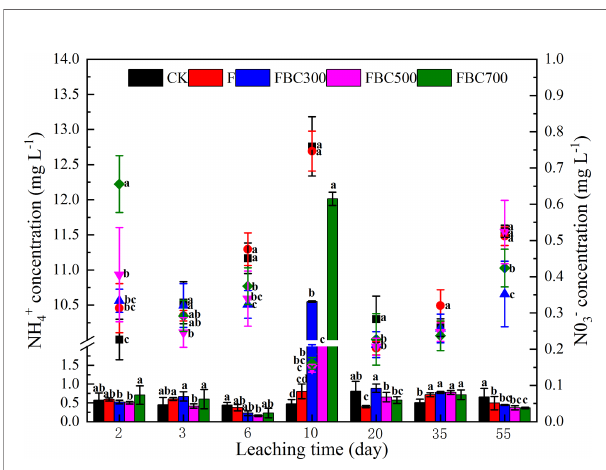
FIGURE 3 | Dynamic changes of surface water ammonium nitrogen (NH + 4 ) and nitrate nitrogen (NO − 3 ) during 55 days column leaching of paddy soil incorporated with or without biochar amendments and/or fertilizer (i.e. CK: Control treatment without biochar and fertilizer; F: Only fertilizer added; FBC300: 300°C biochar combined with fertilizer; FBC500: 500°C biochar combined with fertilizer; FBC700: 700°C biochar combined with fertilizer). Point and bar represent mean values. Standard deviation and error bars are also presented. Scatter diagram represented NO − 3 N dynamic changes. Column chart represented NH + 4 -N dynamic changes. Letters represent the different statistical classes among the treatments at p <0.05.